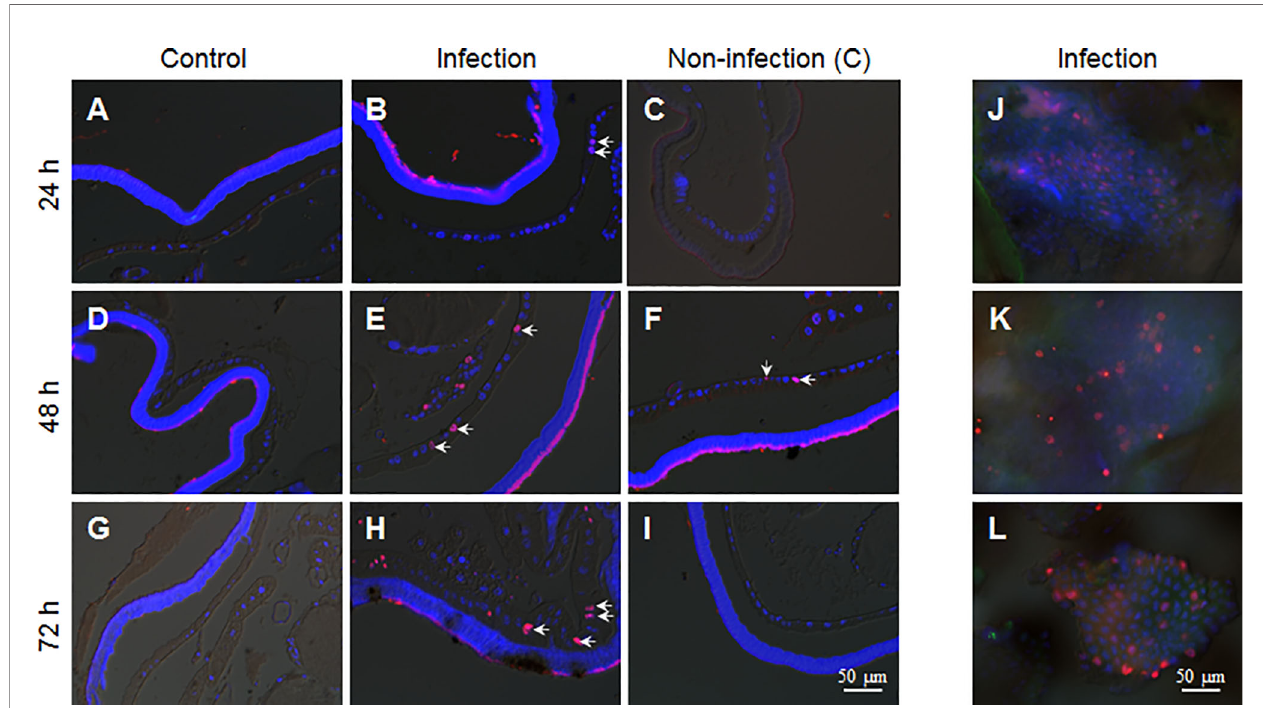
FIGURE 5 | B. bassiana infection induces DNA duplication in epidermis cells. BrdU was injected 3 h before sampling. The integuments that received the fi xed-site infection were sampled via tissue section or immuno-staining directly. The non-infection integuments, as indicated in Figure 1A , were also sampled. (A, D, G) No DNA duplication was detected in epidermis cells of naive larvae. (B, E, H) The fi xed-site infection induced DNA duplication in epidermal cells at each time point assayed. Some of the BrdU-positive nuclei (Red) are indicated by arrows. Some epidermal cells of non-infection segments incorporated BrdU especially at 48 h after infection (C, F, I) . (J – L) Direct staining shows the number of BrdU-positive cells in the integuments that received the fi xed-site infection. Nuclei were counter-stained by